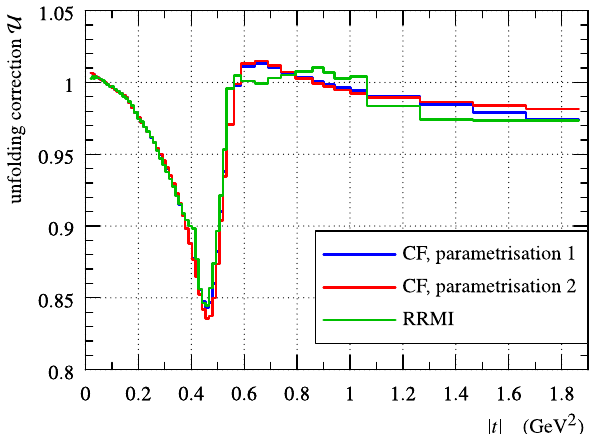
Fig. 1 Unfolding correction, U , as a function of | t | . The different colours correspond to various determination techniques, see